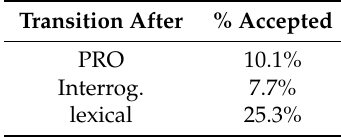
Table 1. Results of acceptability judgments: mixed Quichua-Media Lengua